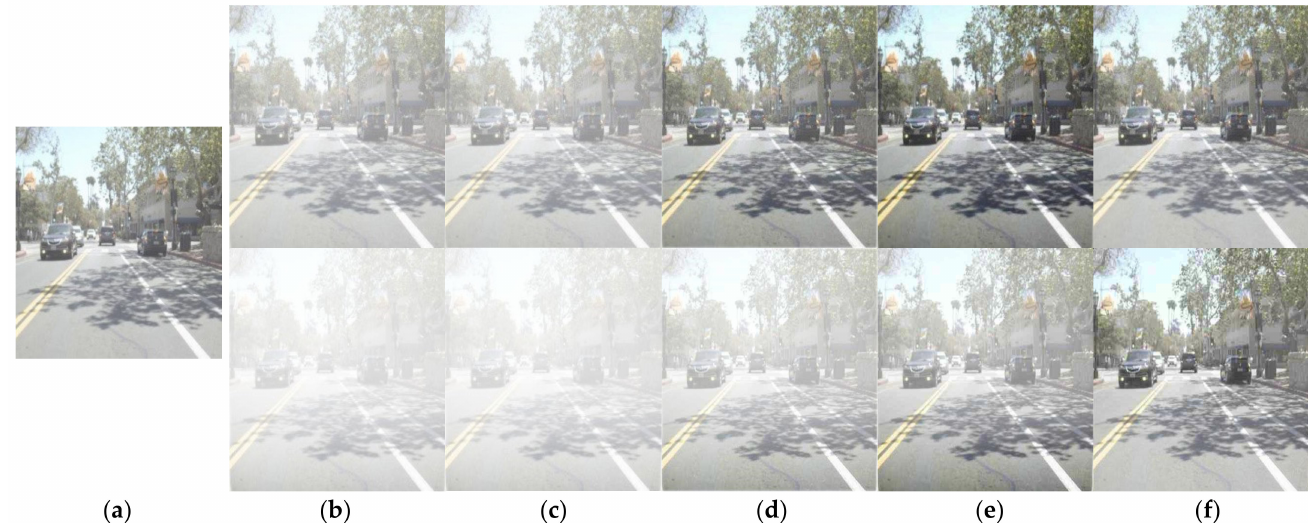
Figure 5. Example of dehazing performance comparison by model (top: light haze, bottom: dense haze); ( a ) original, ( b ) hazed image, ( c – f ) dehazed image by [23,24,33], and DN-RTD,